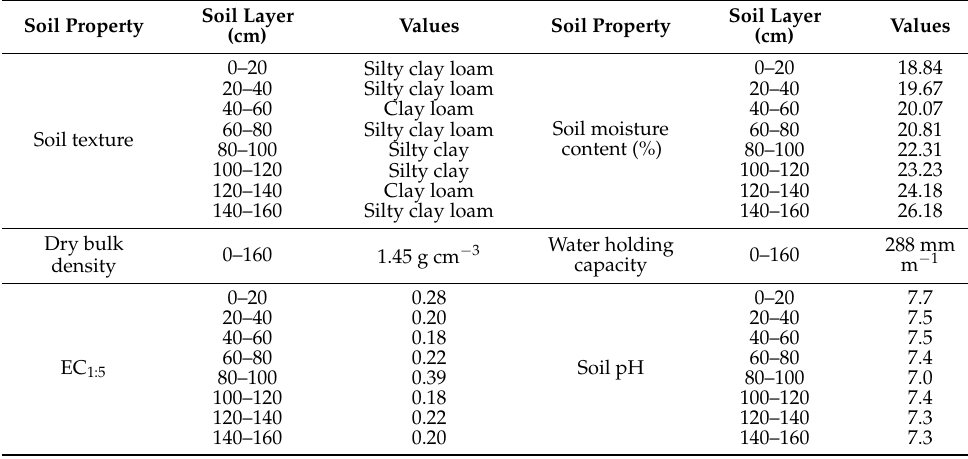
Figure 1. Monthly air temperature (minimum, maximum, and average °C), rainfall (mm), ET o (mm), and relative humidity of experimental site. Table 1. The basic properties of initial soil profile up to 0–160 cm depth.